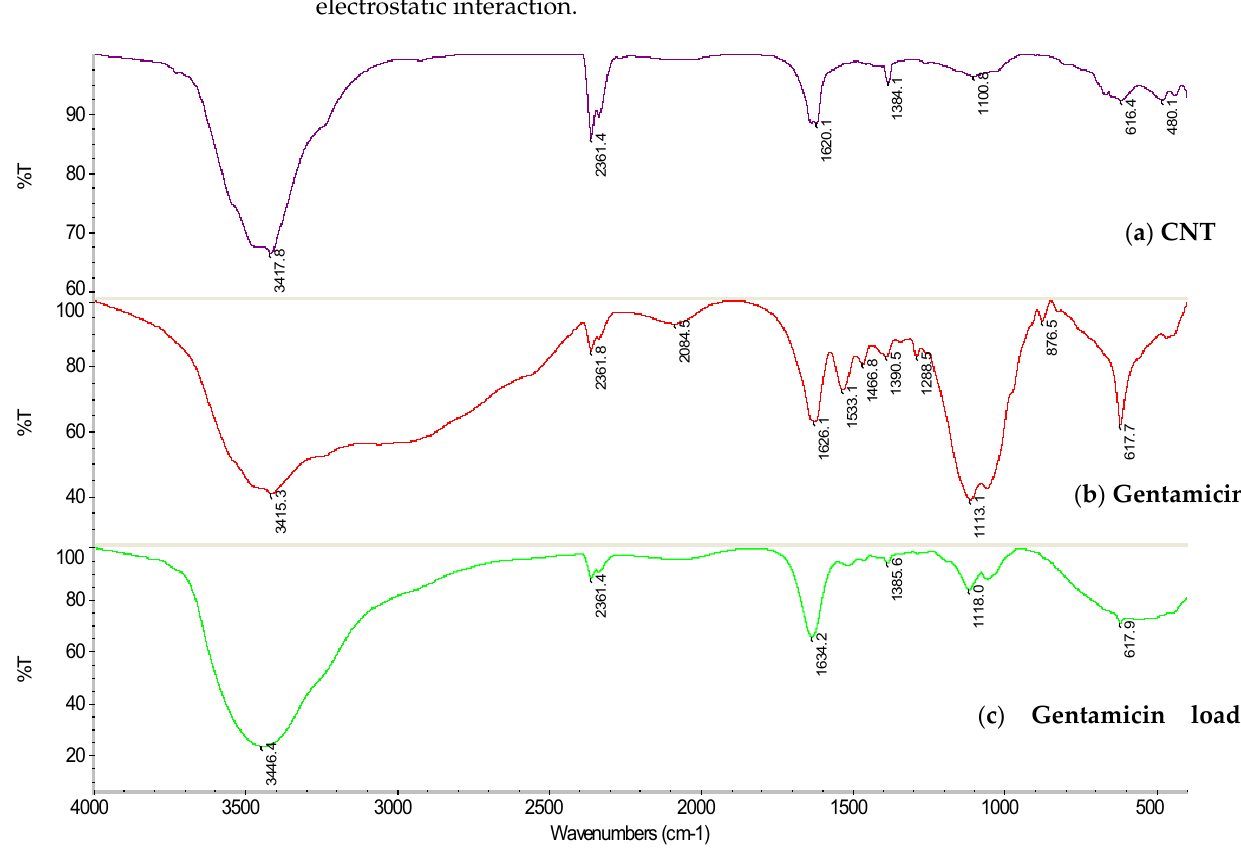
Figure 2. FTIR spectra for ( a ) CNTs, ( b ) gentamicin, and ( c ) gentamicin-loaded CNTs. Zeta potential measurements were performed for the CNT, gentamicin, and gentamicin-loaded CNTs (Figure 3). The zeta potential for the pure CNTs was negative and reached − 17 mV at pH 7 because of the presence of carboxylate groups. Gentamicin had a small zeta potential close to zero, because it is a weak polyelectrolyte with only five ionizable amino groups that become protonated, giving a positive charge. Gentamicin-loaded CNT zeta potential was close to zero because of the neutralizing effect of the electrostatic interaction between the amino group of gentamicin and the carboxylate group on CNT.